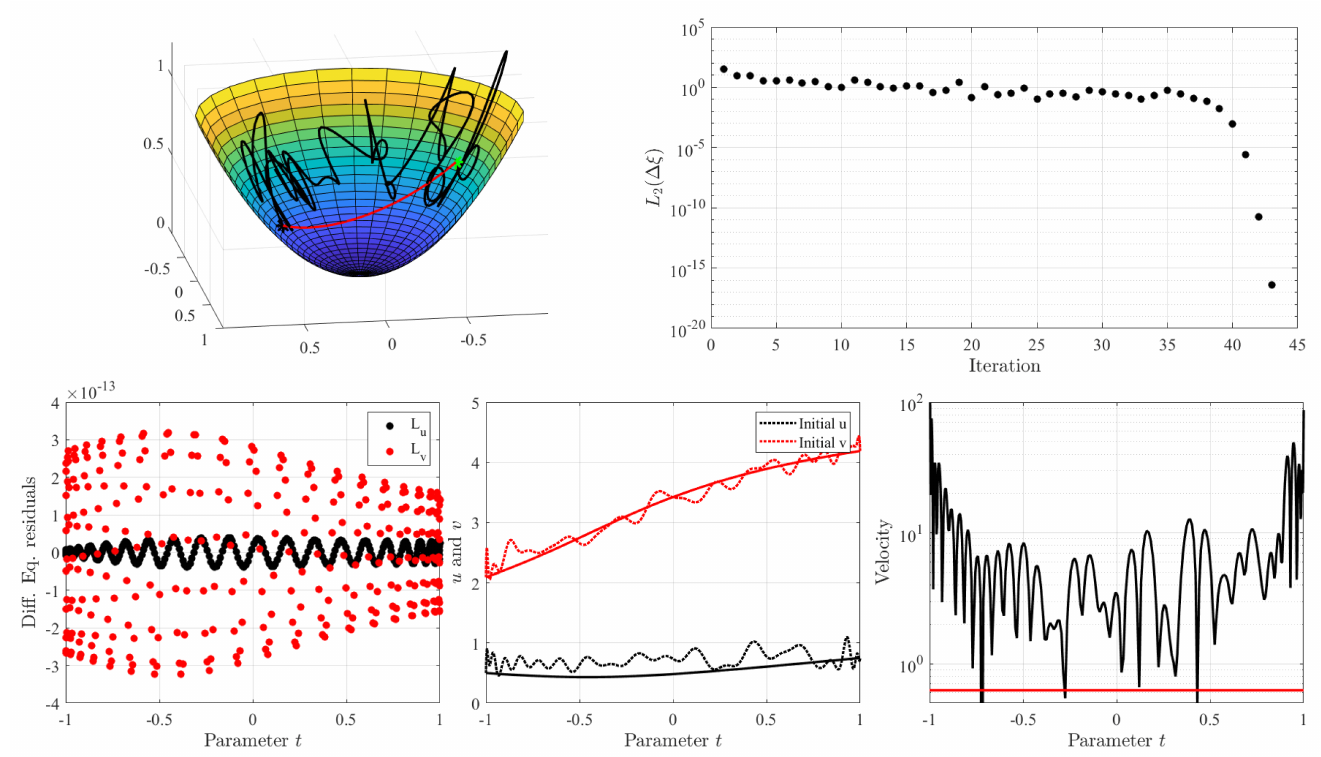
Figure 4. Elliptic paraboloid test